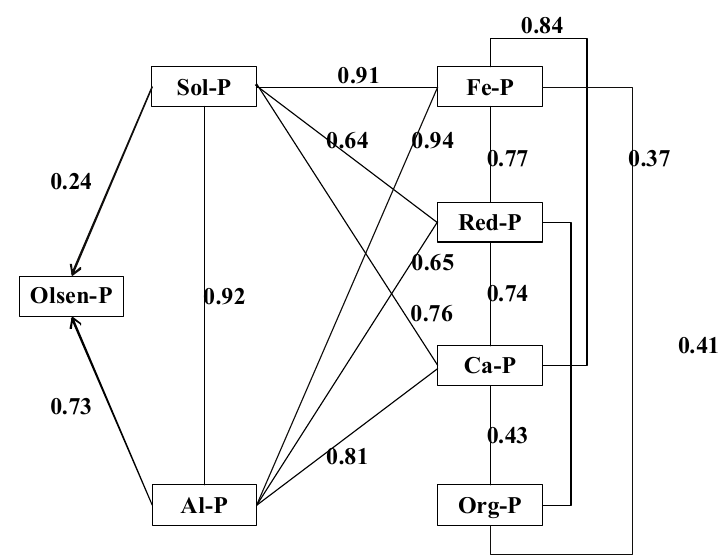
Figure 7. Direct and indirect coefficients between P fractions and Olsen-P.